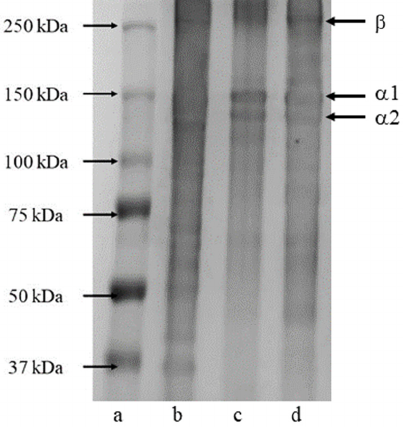
Figure 5. SDS-PAGE analysis of ( a ) protein marker, ( b ) type I calf collagen, ( c ) the extracted product from the skin, ( d ) the extracted product from the bone.